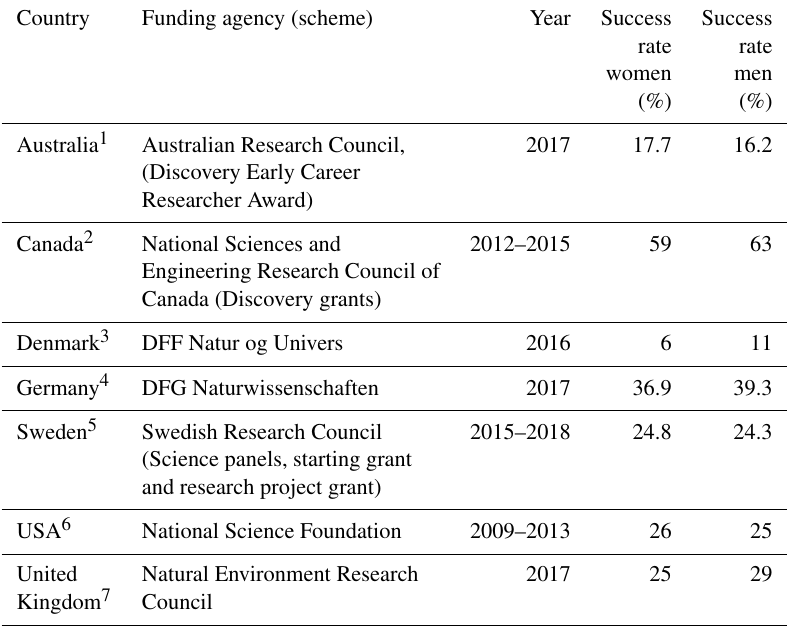
Table 2. National individual grants with reported success rates per sex. There were no statistical differences between success rates for women and